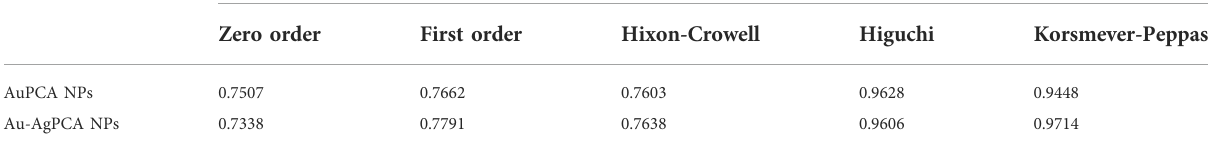
TABLE 3 Kinetic study assessment of AuPCA and Ag-AuPCA based on various kinetic mathematical models. Sample